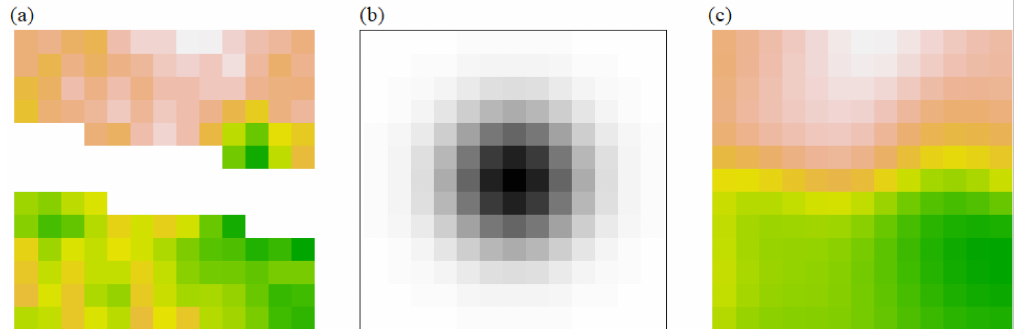
Figure 4. Illustration of choice of Gaussian kernel bandwidth and moving window size: ( a ) NDVI Landsat-7 image acquired 2017-07-30 with SWGC moving window specified by MAXD = 200 centred on gap caused by SLC failure; ( b ) Gaussian weights with bandwidth = b (black is high with the central cell having a weight of 1, and white is close to 0) and ( c ) predicted NDVI using the SWGC